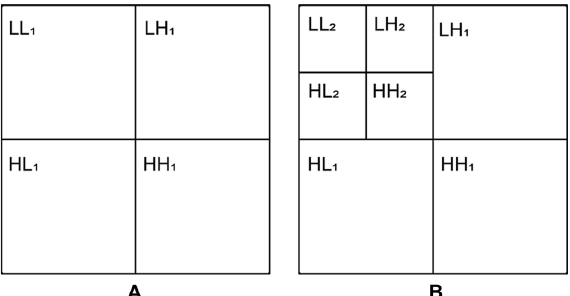
Figure 2. Flowchart of 2-level wavelet transform. ( A ) First level wavelet transform. ( B ) Second level wavelet